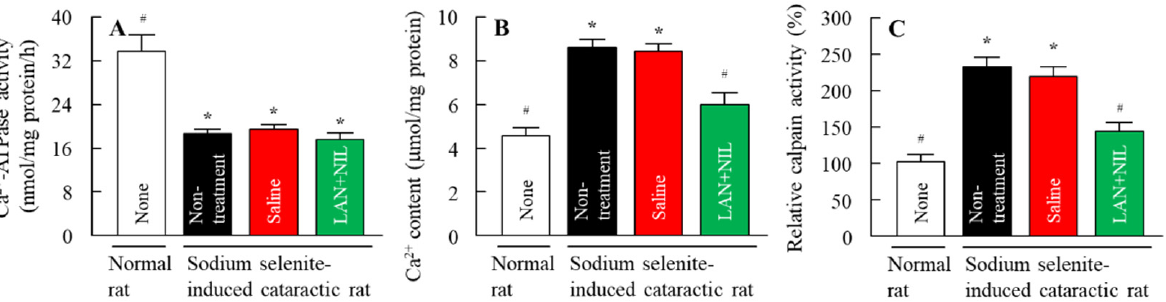
Figure 6. Changes in Ca 2+ –ATPase activity ( A ), Ca 2+ contents ( B ), and calpain activity ( C ) in the lenses of normal and sodium-selenite-induced cataractic rats co-instilled with LAN-ONSs and NIL-ONSs. The instillation was performed at 7 days after the injection of sodium selenite, and the Ca 2+ –ATPase activity, Ca 2+ contents, and calpain activity in lenses were measured 3 h after the instillation. None, normal rats. Non-treatment, sodium-selenite-induced cataractic rats. Saline, sodium-selenite-induced cataractic rats instilled with saline. LAN + NIL, sodium-selenite-induced cataractic rats co-instilled with LAN-ONSs and NIL-ONSs ( n = 6–8). The enhanced Ca 2+ content and calpain activity in the sodium-selenite-induced cataractic rats was significantly alleviated with the co-instillation of LAN-ONSs and NIL-ONSs. * p < 0.05, vs. none (normal rats) for each group. # p < 0.05, vs. saline for each group.